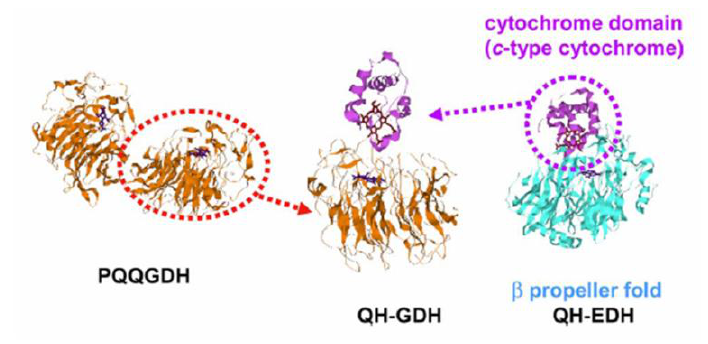
Figure 15. Construction of engineered enzyme (QH-GDH) by fusion of the cytochrome c domain of quinohemoprotein ethanol dehydrogenase (QH-EDH) to the C terminus of PQQ-dependent glucose dehydrogenase (PQQGDH). Reprinted from [121] with permission from